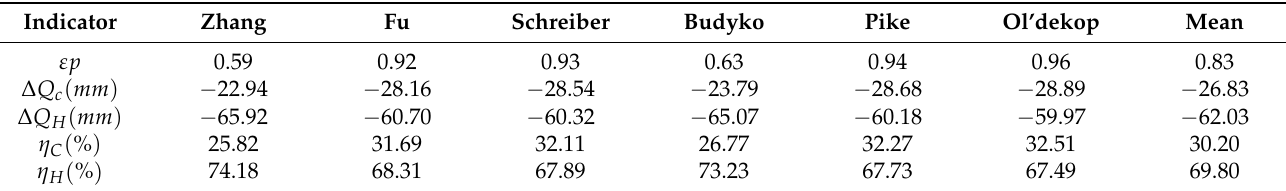
Table 5. Calculation results of alterations in the runoff regime.